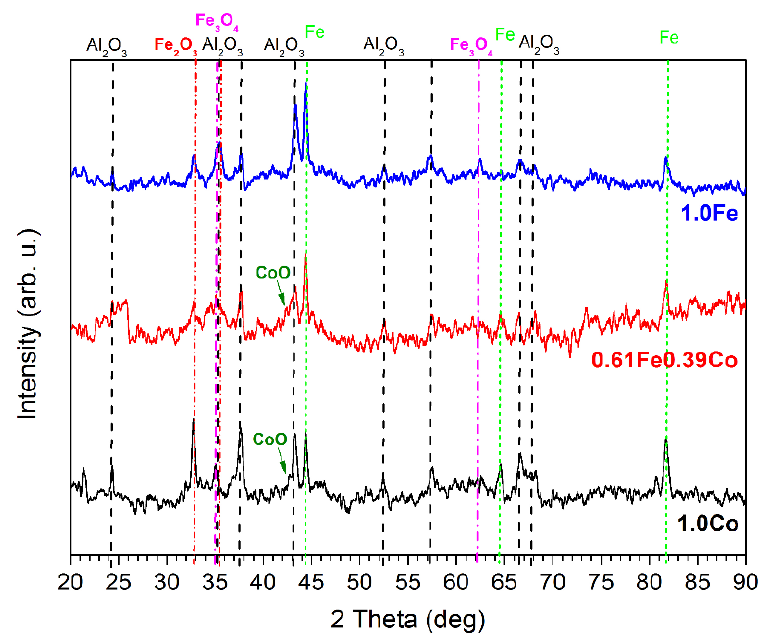
Figure 3. XRD patterns for 1.0Co ( black ), 1.0Fe ( blue ) and 0.61Fe0.39Co ( red ) thin films.